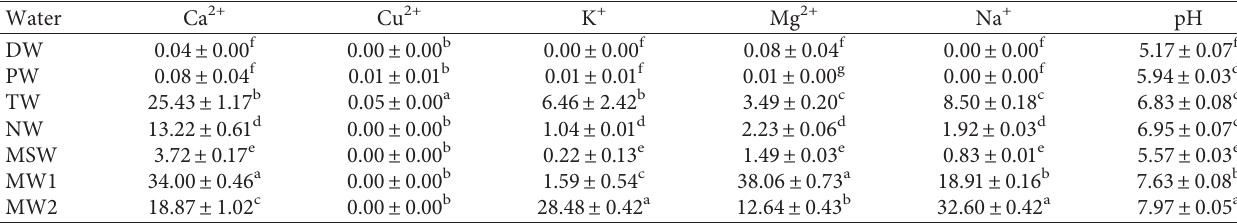
Table 1: The mineral concentrations (mg/L) and pH value of different types of water.